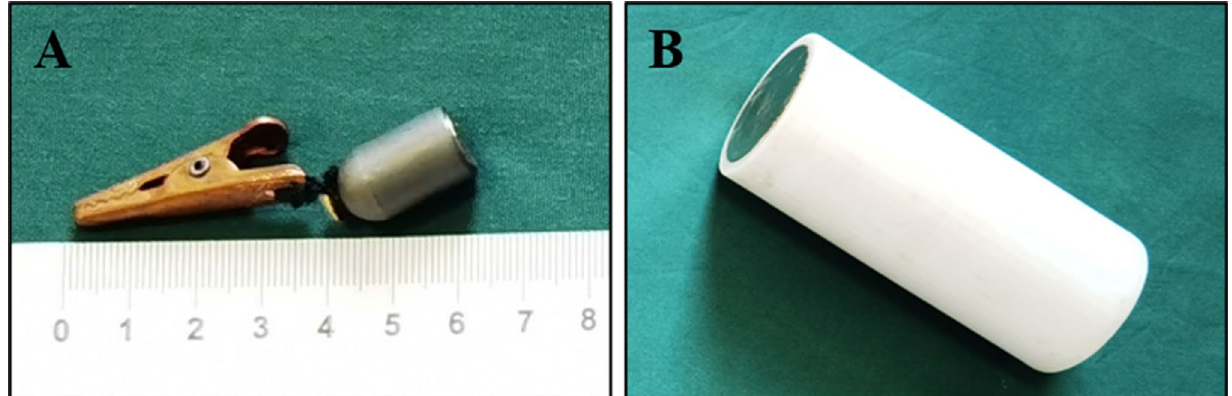
Figure 1. Magnetic anchoring device. ( A ) The internal grasper. ( B ) The anchoring magnet.